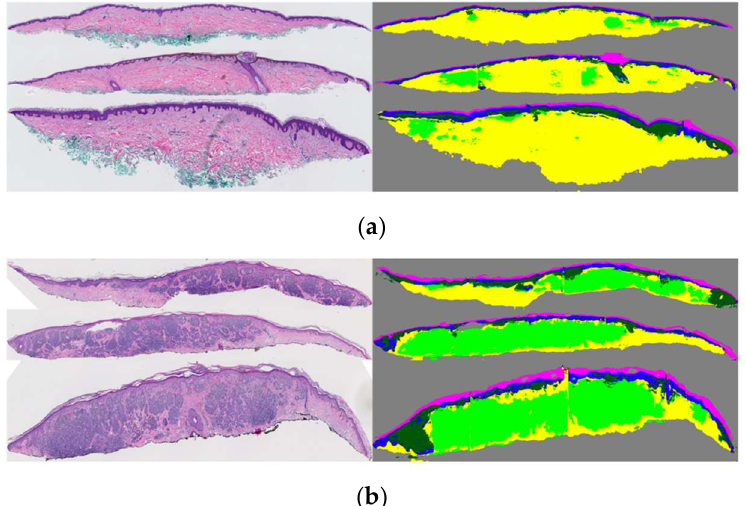
Figure 6. Example of dermal nest segmentation (in light green) on WSI: ( a ) a moderate nevi case; all the dermal nests are nevi type. ( b ) An invasive melanoma stage ≥ T1b case; the segmented dermal nests might contain both nevi and melanoma dermal nests.